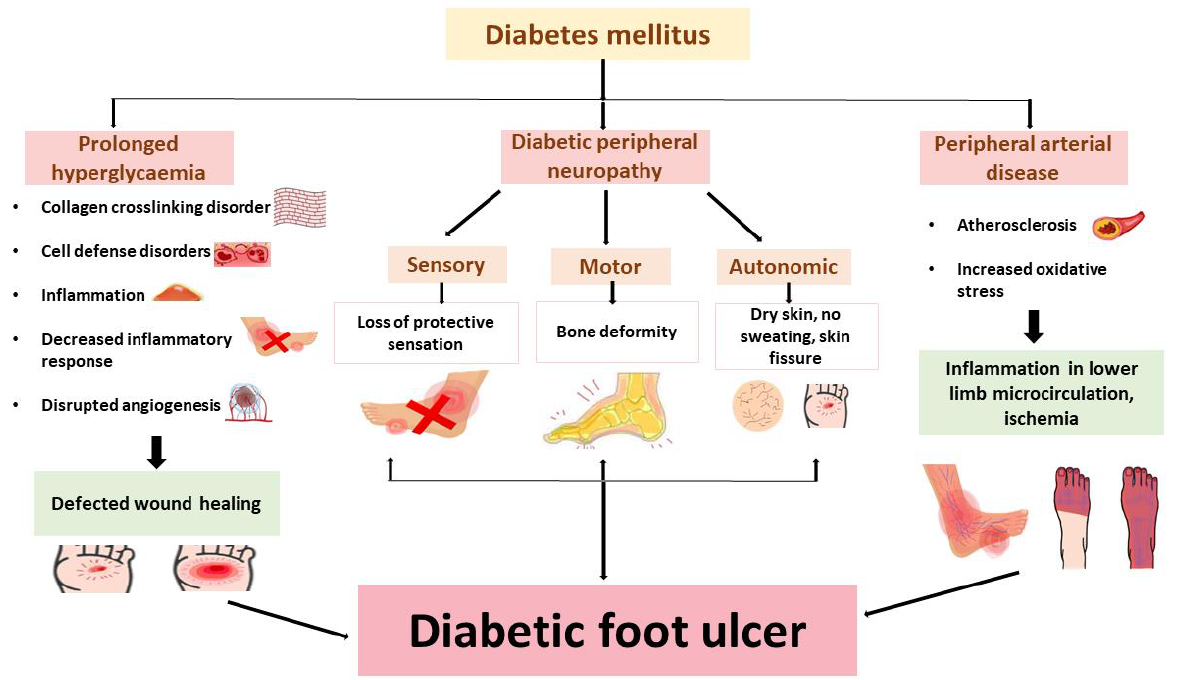
Figure 2. Diagrammatic synopsis of the etiology of diabetic foot ulcers involving prolonged hyperglycemia, diabetic peripheral neuropathy, and peripheral arterial diseases. The sustained hyperglycemia impairs the wound-healing process via collagen crosslinking disorder, cell defense disorders, decreased inflammatory response, and disrupted angiogenesis; peripheral neuropathy affects the sensory, motor, and autonomic nervous systems, causing protective sensation loss, bone deformation, dry skin, skin fissures, and infections; peripheral arterial diseases such as ischemia, inflammation in lower limb microcirculation, and high plantar pressure in the foot can occur from atherosclerosis and elevated oxidative stress.